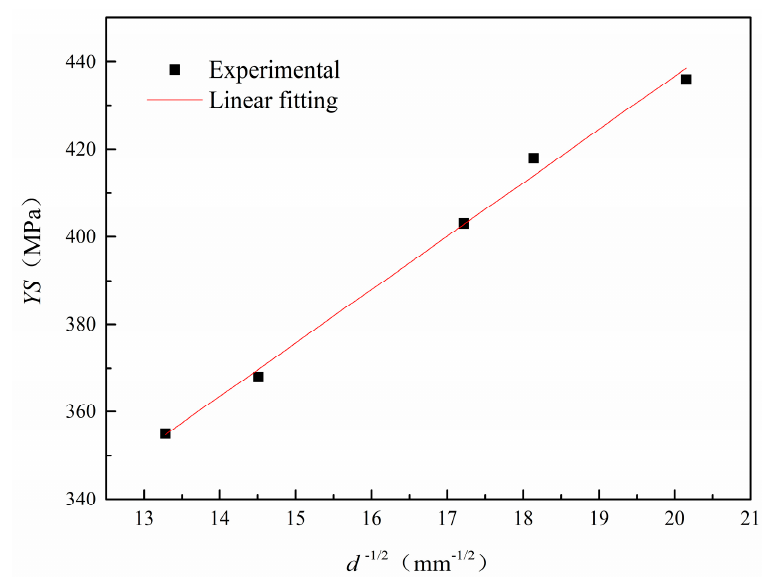
Figure 11. YS vs. d –1/2 for different CP samples. YS —yield strength, CP—cooling path, d —effective grain size.